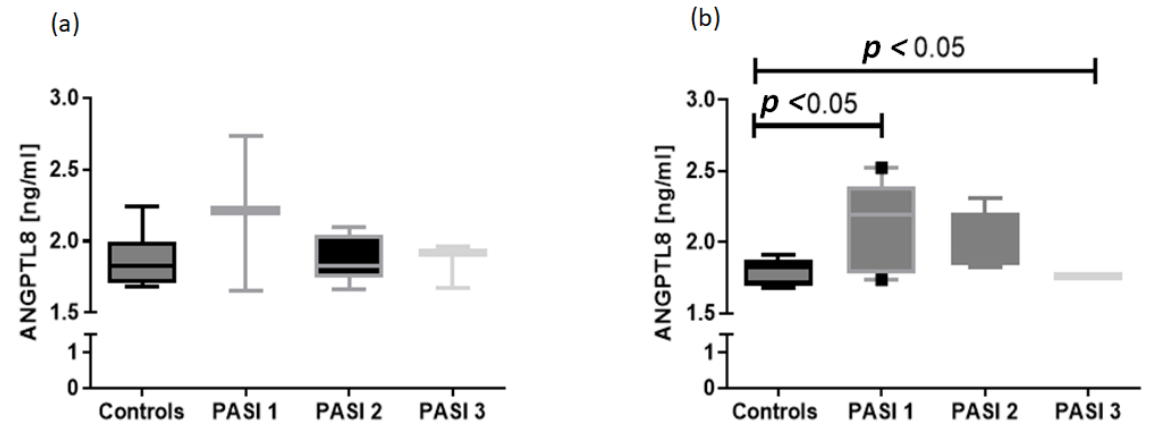
Figure 2. Comparison between ANGPTL8 serum concentration before ( a ) and after ( b ) treatment compared to controls, and after division into subgroups based on psoriasis severity expressed by PASI. Table 3. Comparison between ANGPTL8 serum concentrations before and after treatment in sub- groups of psoriatic patients divided according to BMI, and in controls without psoriasis.